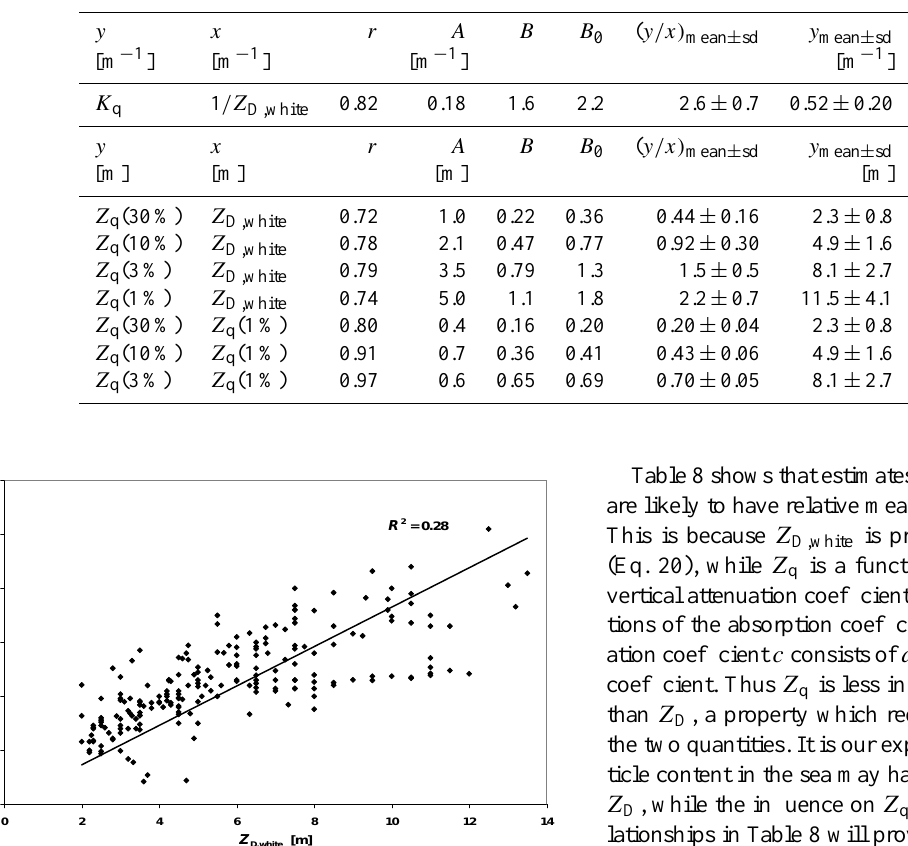
Table 8. Linear relationships of the forms y = A + Bx and y = B 0 x , obtained by correlation analysis of the vertical attenuation coefficient K q of downward quanta irradiance, the depths Z q (p %) where the quanta irradiance is reduced to p percent of the surface value, and the Secchi disk depth Z D,white . The error ε is the root mean square of the deviations ( y – A – Bx ), ε 0 is the rms of ( y – B 0 x) , and r is the correlation coefficient. The analysis is based on 205 stations.